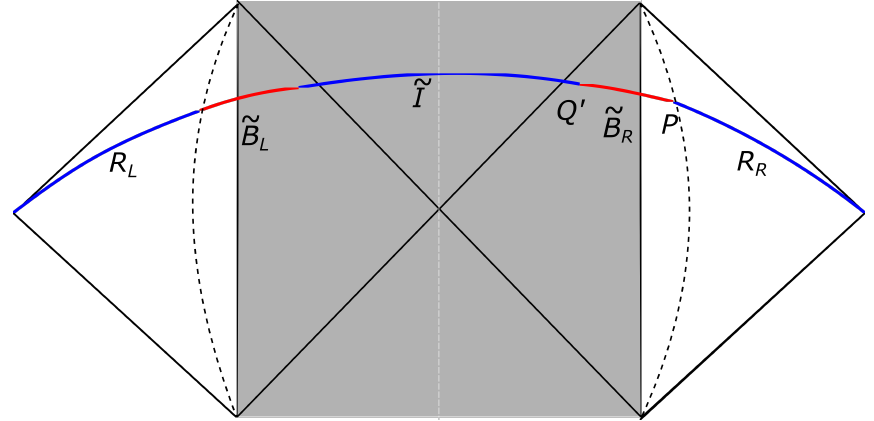
Figure 22: Schematic for the mixed state configuration of the adjacent intervals in the bath and the black hole. Figure modified from [ 69